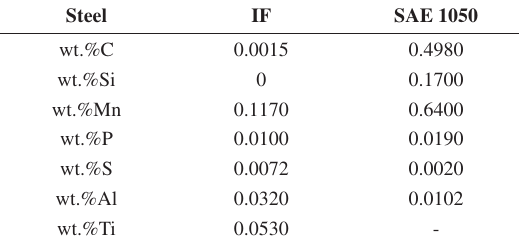
Table 1. Analyzed composition of the investigated steels.